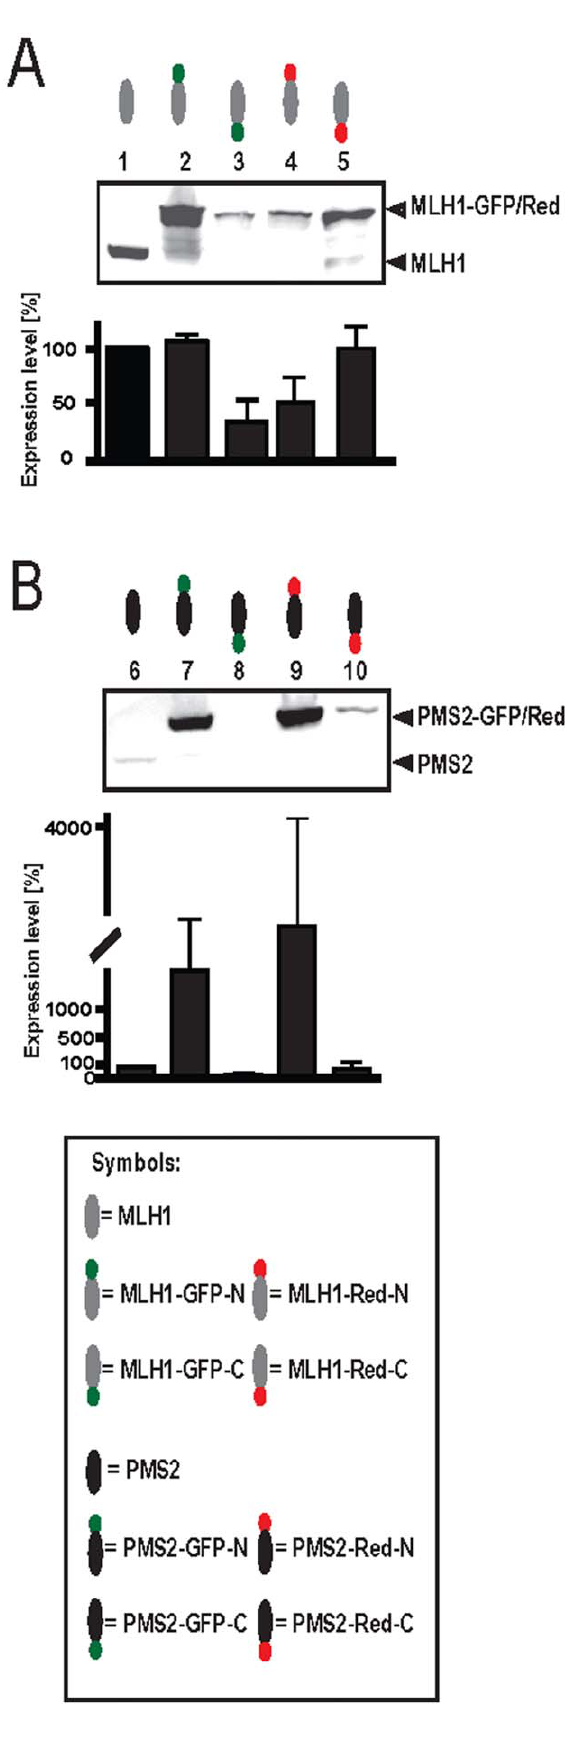
Figure 1. Dye tags influence single expression of MLH1 and PMS2. To determine the influence of fluorescent tags on single expressed MLH1 or PMS2 variants, HEK293T cells were transfected with different (A) MLH1 or (B) PMS2 constructs. Amounts of expressed proteins were assessed after Western blotting by measuring the signal intensities of protein bands with Multi Gauge V3.2 software. Graphs indicate the results (mean 6 S.D.) of at least four independent experiments in which the proportion of protein expression using an unbiased method were presented. 1: MLH1 unlabeled; 2: MLH1-GFP-N; 3: MLH1-GFP-C; 4: MLH1-Red-N; 5: MLH1-Red-C; 6: PMS2 unlabeled;